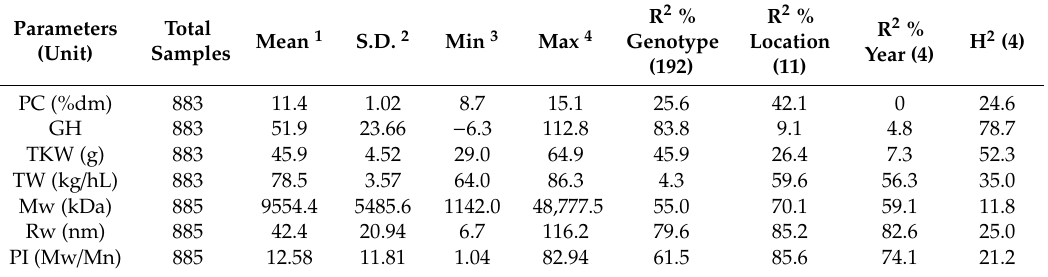
Table 1. Values of statistical distribution of the 192 cultivars experimented in 11 locations for protein content (PC); grain hardness (GH); thousand kernel weight (TKW); test weight (TW); and the polymer characteristics: molecular mass (Mw), gyration radius (Rw), and polydispersity index (PI). The percentage ( R 2 %) of phenotypic variance was obtained using one factor ANOVA, and the heritability H 2 coe ffi cient was averaged over the H 2 computed per experimental